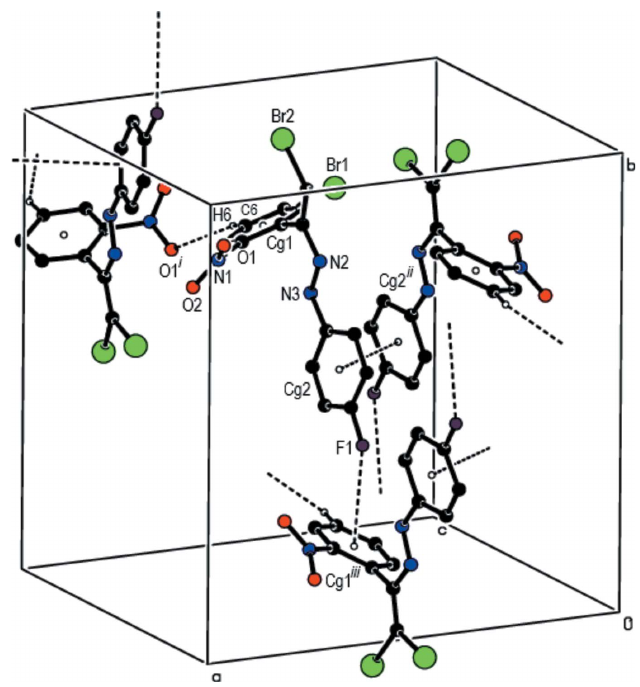
Figure 2 View of the C—H (cid:2)(cid:2)(cid:2) O, C—F (cid:2)(cid:2)(cid:2) (cid:2) and (cid:2) – (cid:2) stacking interactions in the